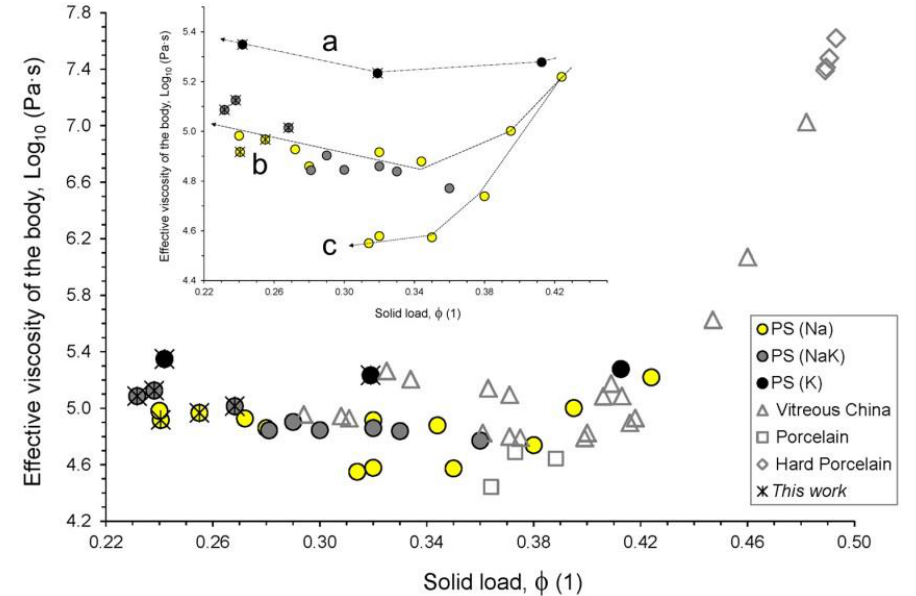
Figure 9. Effective viscosity of the ceramic bodies in function of its solid load (normalized to 1). About porcelain stoneware, three different trends can be seen (see inset, lines are reader’s eye guides): ( a ) potassic bodies; ( b ) sodic and sodic-potassic bodies; ( c ) sodic bodies with high (MgO + CaO)/GNM ratio.